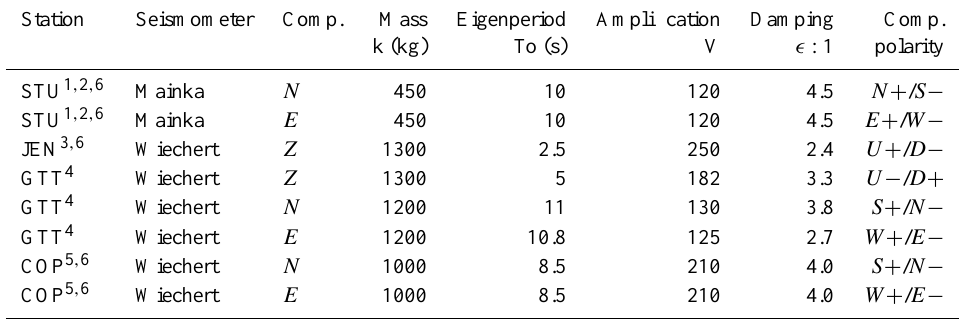
Table 4. Instrument parameters that seismograph systems of the recorded analogue seismograms used in the present study. Component polarity in writing direction: left is up (+), right is down ( − ).